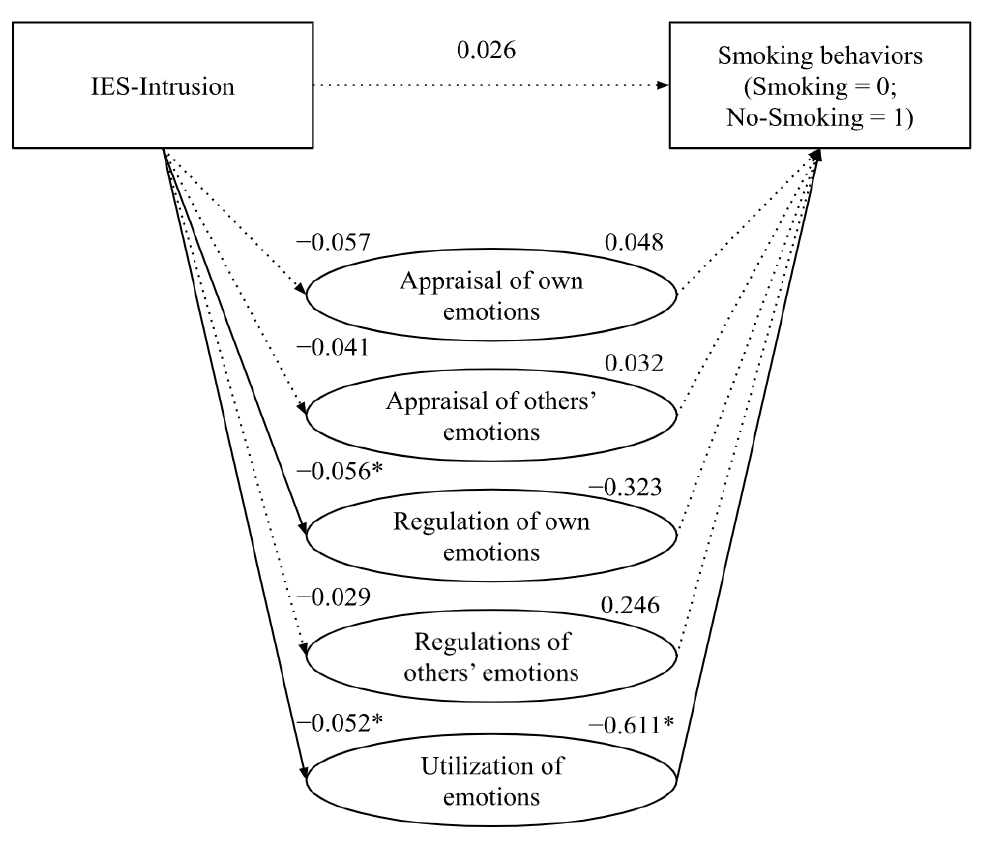
Figure 1. Partial mediation effect of emotional intelligence on the relationship between intrusion and smoking behaviors. Note . * p < 0.05.